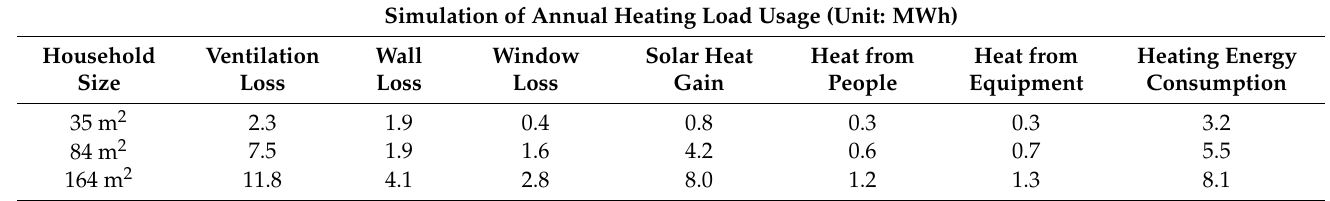
Table 7. Annual heating load usage according to the growth in house size (EnergyPlus).